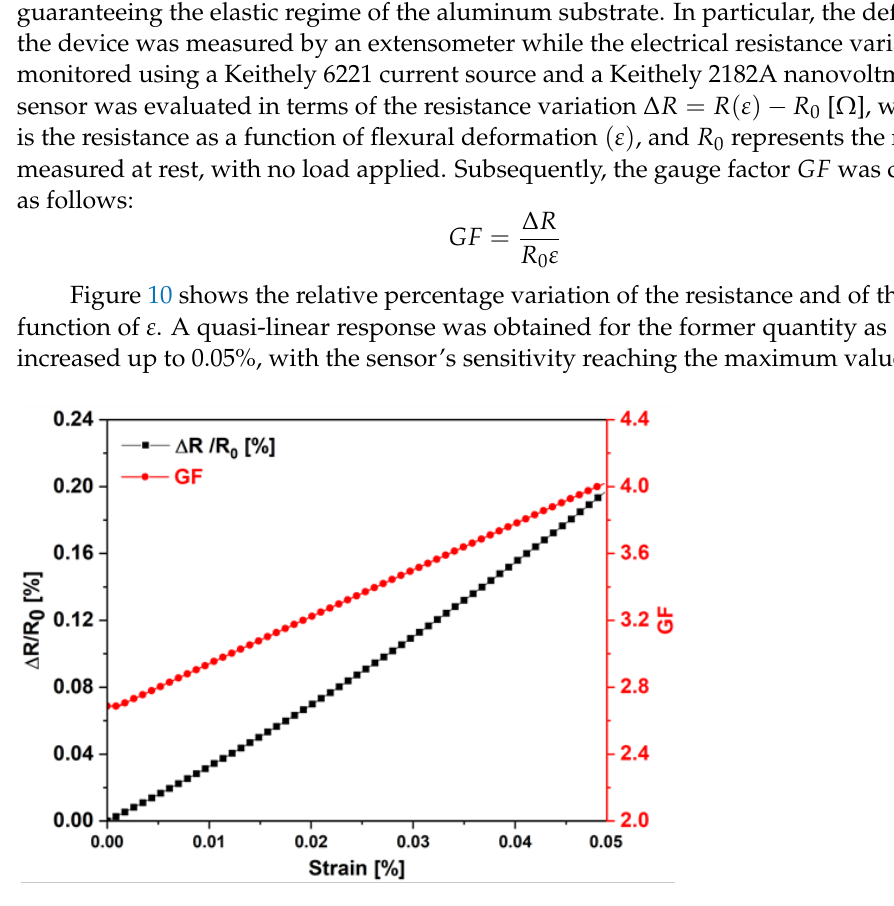
Figure 11. Set-up used to perform the different tests on the prototype with the array of strain sensors (w = 15 cm; l = 15 cm; d = 10 cm).